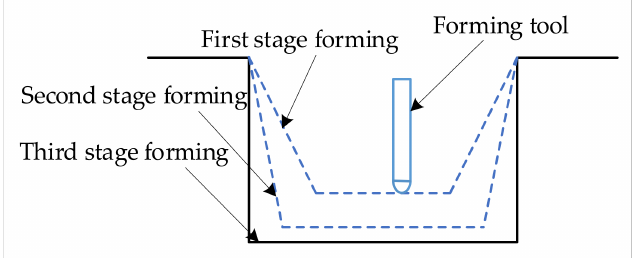
Figure 2. Negative multistage incremental